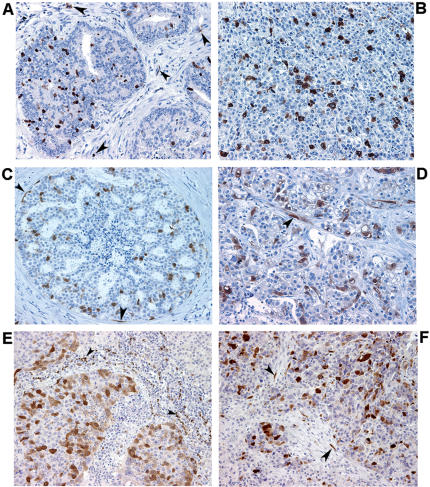
Histological pattern of securin expression in human cancers.Representative images of securin expression in human cancer samples.Securin expression (brown) is observed in tumor and stromal (arrowheads) cells in (A) late-stage PIN and (C) breast carcinoma in situ tissue sections.Invasive cancer stages of (B) prostate, (D) breast, (E) lung, and (F) ovarian cancers show strong securin expression by both tumor and stromal (arrowheads) cells.Nuclei were counterstained with haematoxylin.Magnification 200×.